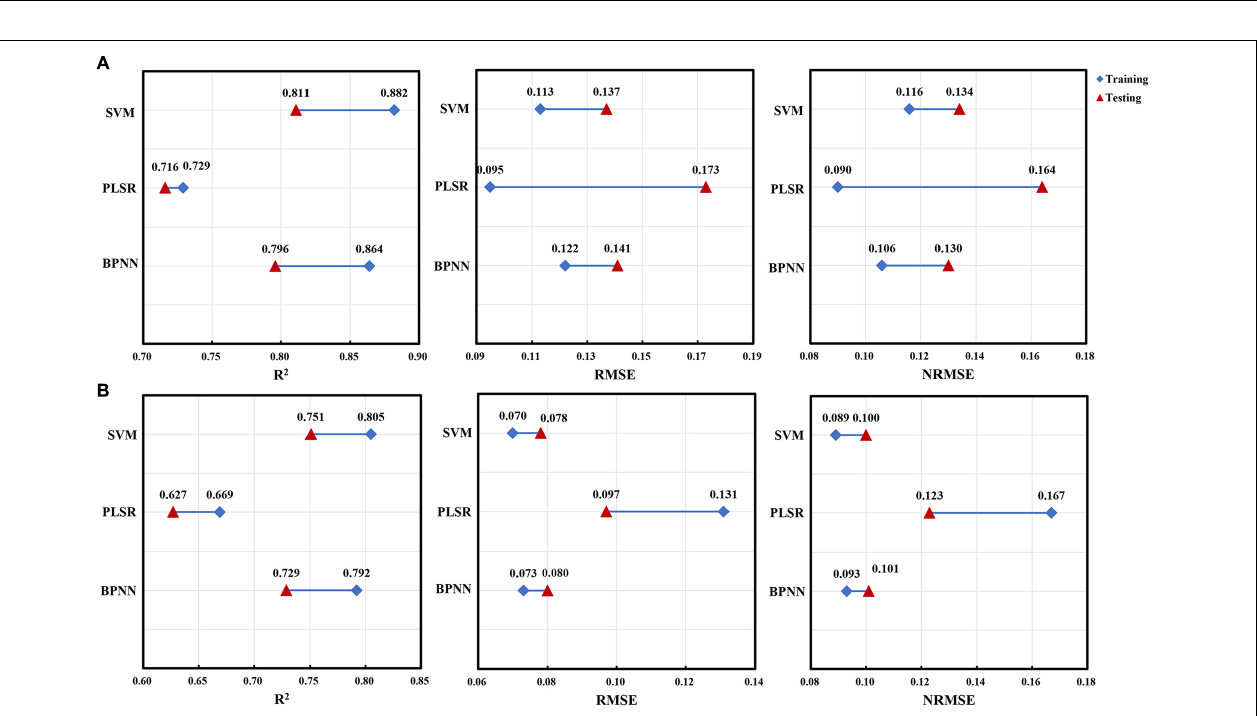
FIGURE 8 | The difference between the performance indicators for AGB estimation of red bean and mung bean using three machine learning methods within training and test datasets. (A) Red bean; (B) mung bean.